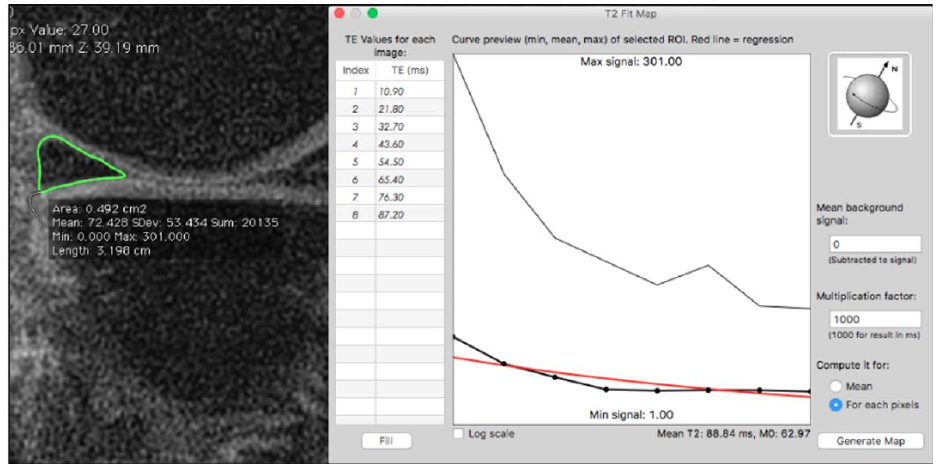
Figure 2. Meniscal segmentation and software graphic interface to estimate quantitative T2 mapping curve.